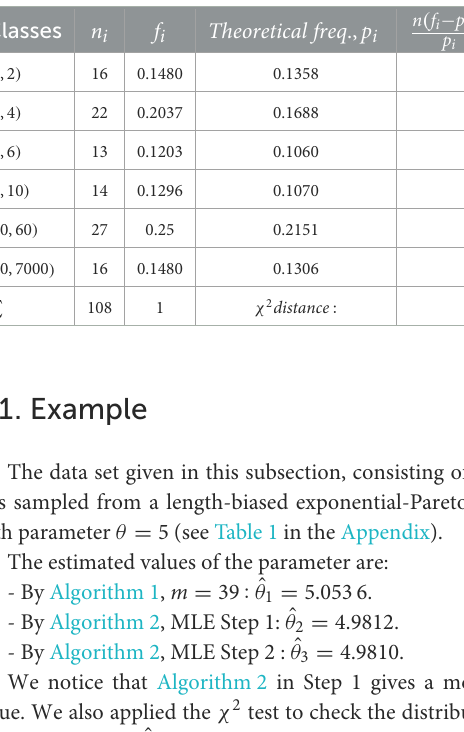
Algorithm 2. Estimate θ using